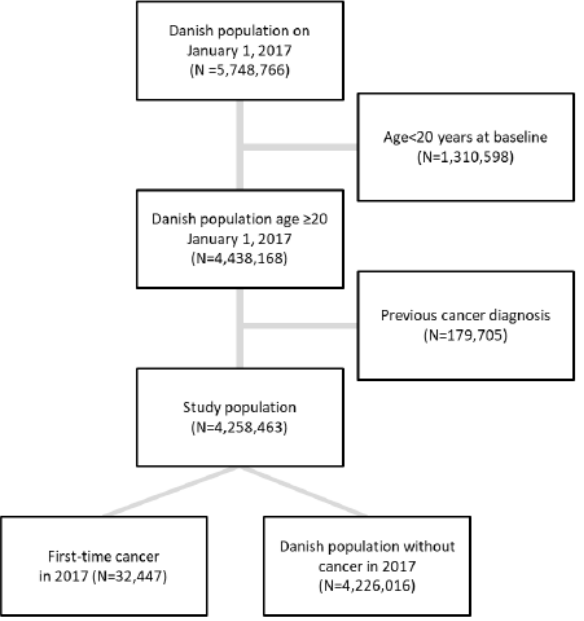
Figure 1. Flow of participants for the CRAM model predictions .